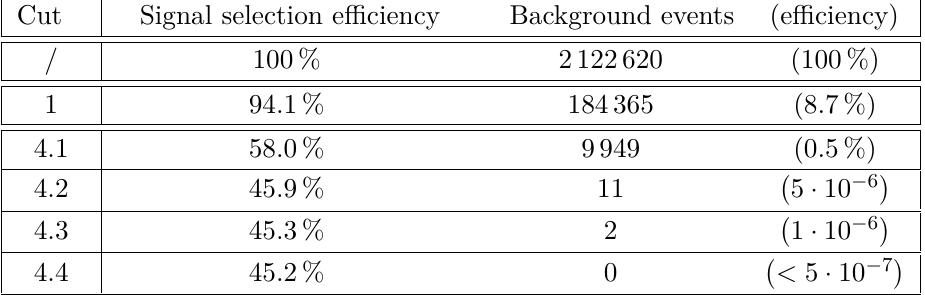
Table 3 . Signal and background selection efficiencies and number of background events for event preselection (cut 1) and consecutive final event selection cuts in the reference signal and 10 megaton · years background samples. Although the background can be completely rejected in the studied sample, rare irreducible background events can not be excluded for larger exposures and the background efficiency is therefore given as upper limit after the last